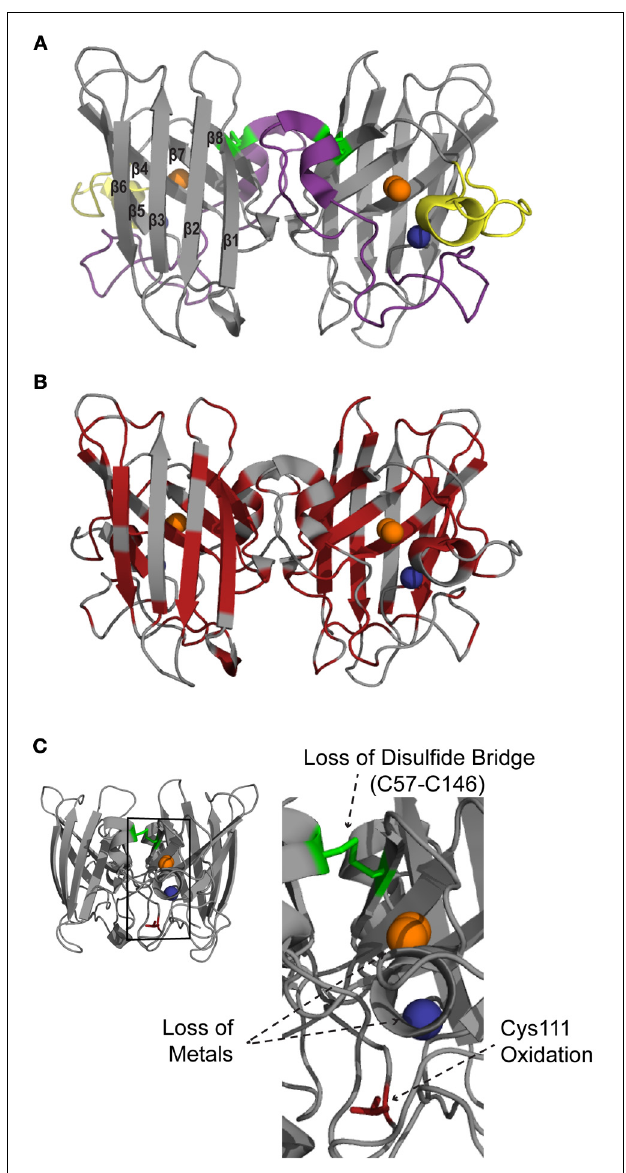
FIGURE 1 | Structural features of SOD1. SOD1 is a homodimer with one copper (orange) and one zinc (blue) per subunit (PDB:2C9V). (A) SOD1 consists of eight beta sheets that form the beta barrel core. The major functional loops are the zinc binding loop (purple; residues 49–81) and electrostatic loop (yellow; residues 124–139). An intramolecular disulfide bond (C57–C146; green) stabilizes the protein structure. (B) Mapping the ALS-linked mutations (red) onto the structure of SOD1 illustrates that these mutations are present throughout the entire protein. (C) Alterations to normal post-translational modifications, such as loss of the disulfide bridge (C57–C146; green), demetallation and monomerization (not shown), as well as aberrant modifications such as oxidation of amino acid side chains (shown for Cys 111; red), cause WT SOD1 to misfold.